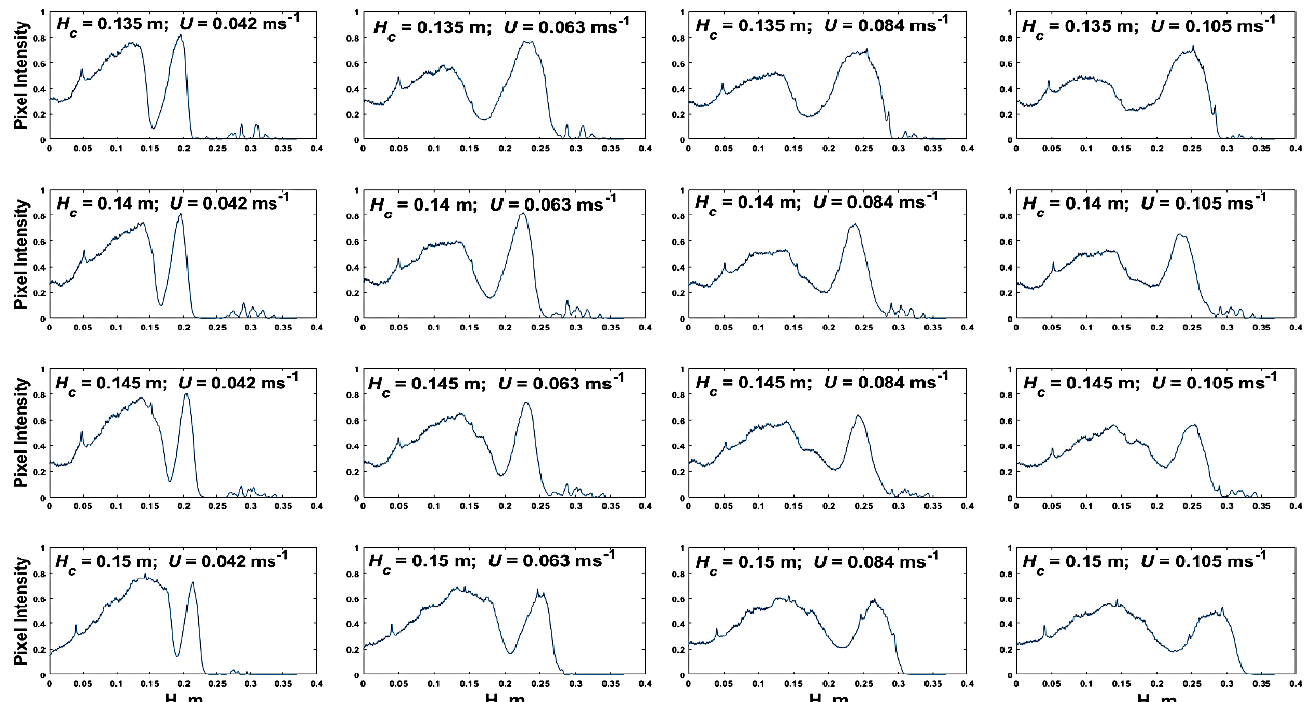
Figure 6. Variation of pixel intensity (axially) with U and H c .